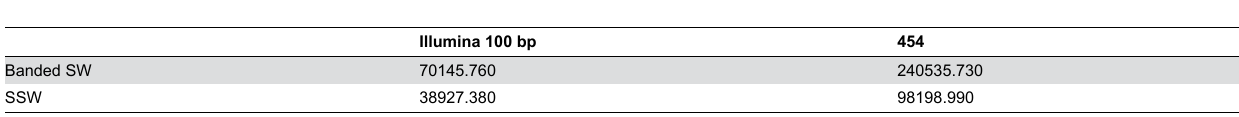
Table 1. Comparison of the running time (seconds) between the banded SW engined MOSAIK and the SSW engined